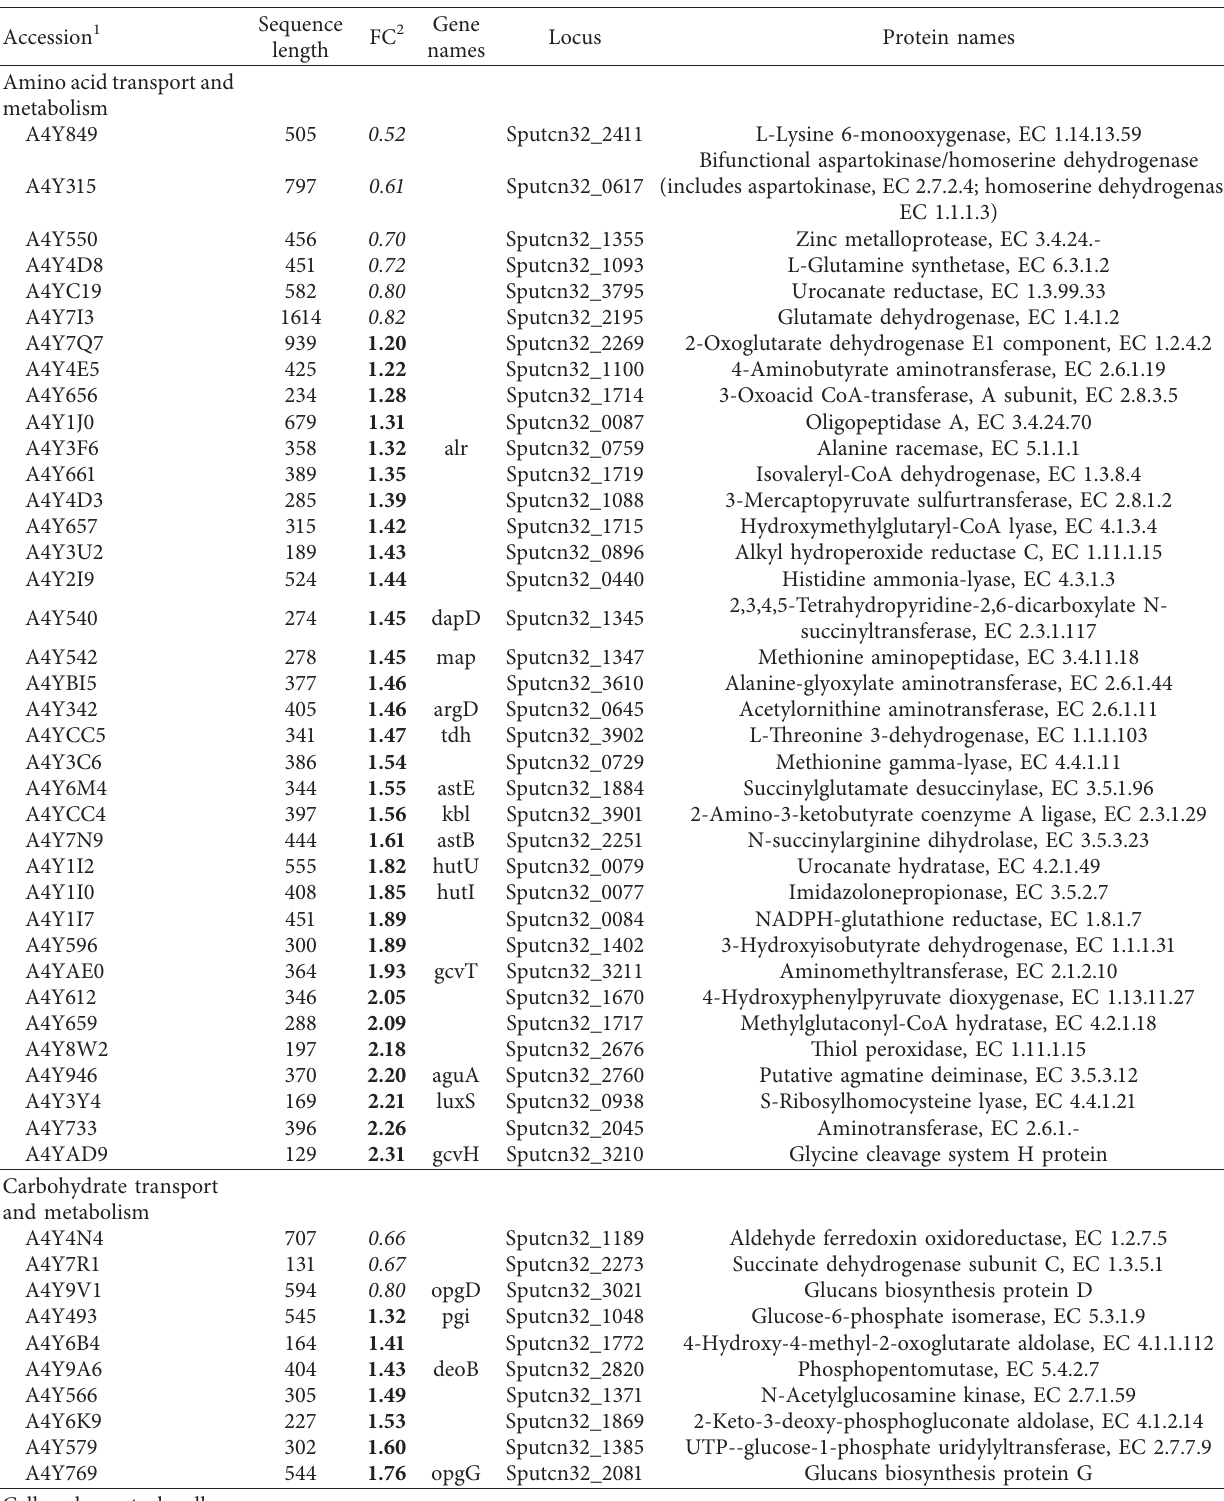
Table 1: Detailed information regarding upregulated and downregulated differentially expressed proteins in S. putrefaciens cultivated at 4 ° C and 30 °